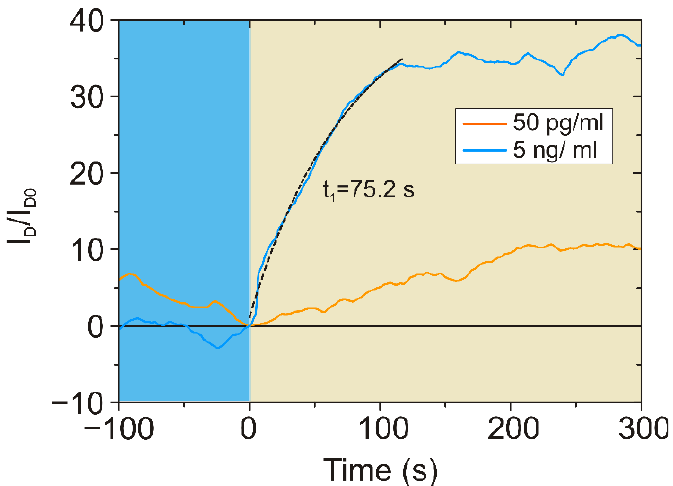
Figure 4. Time-dependent measurement changes in relative drain current I D for different concentra- tions of NT-proBNP in 0.1xPBS, without regeneration, V G = 100 mV and V DS = 100 mV. The response time t 1 was calculated in single-exponent approximation.